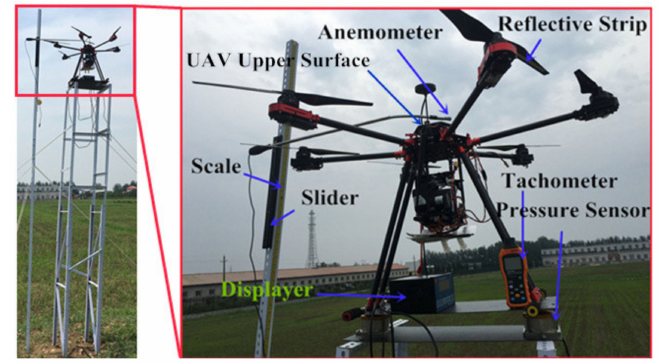
Figure 2. Experimental configuration to measure propeller gas flow and rotation speed of the UAV. Left: overall structure of platform; Right: details of the